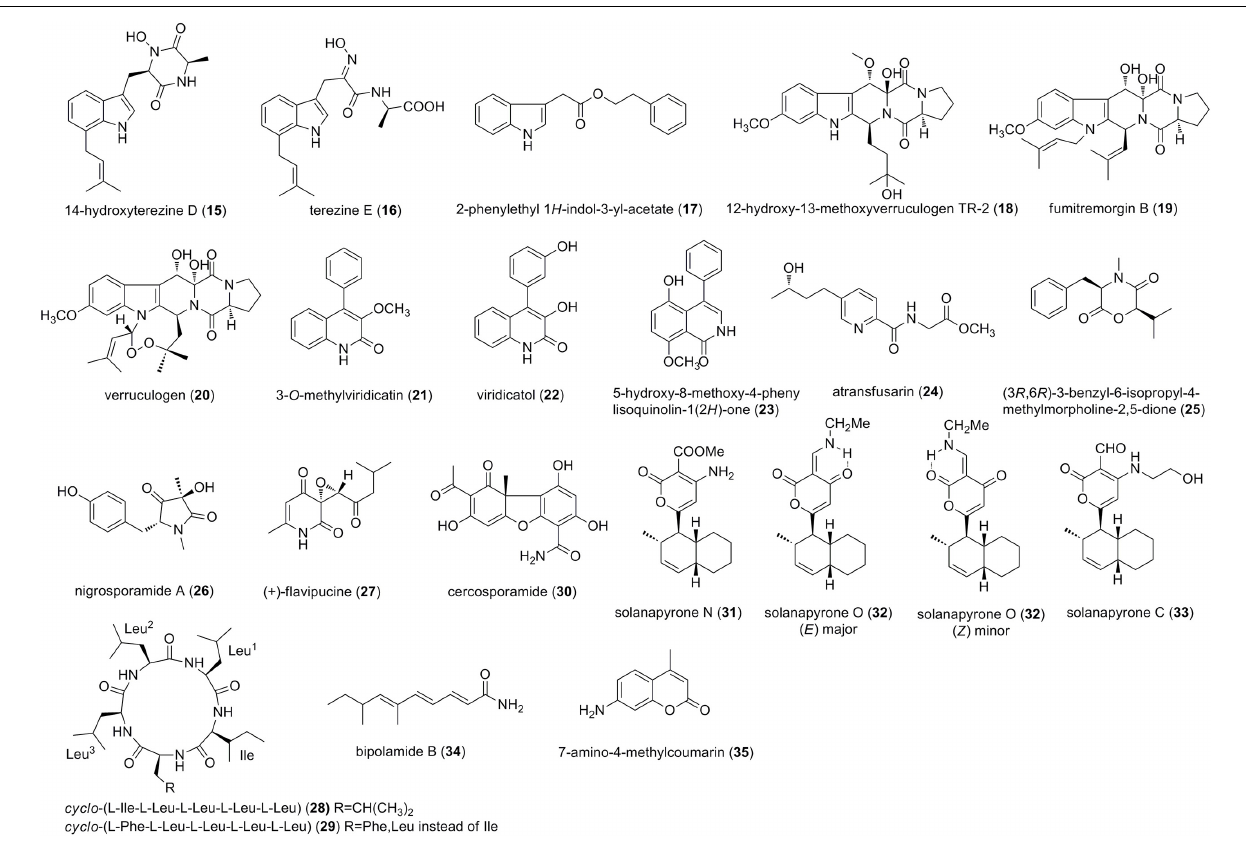
FIGURE 2 | Other alkaloids characterized from endophytic fungi